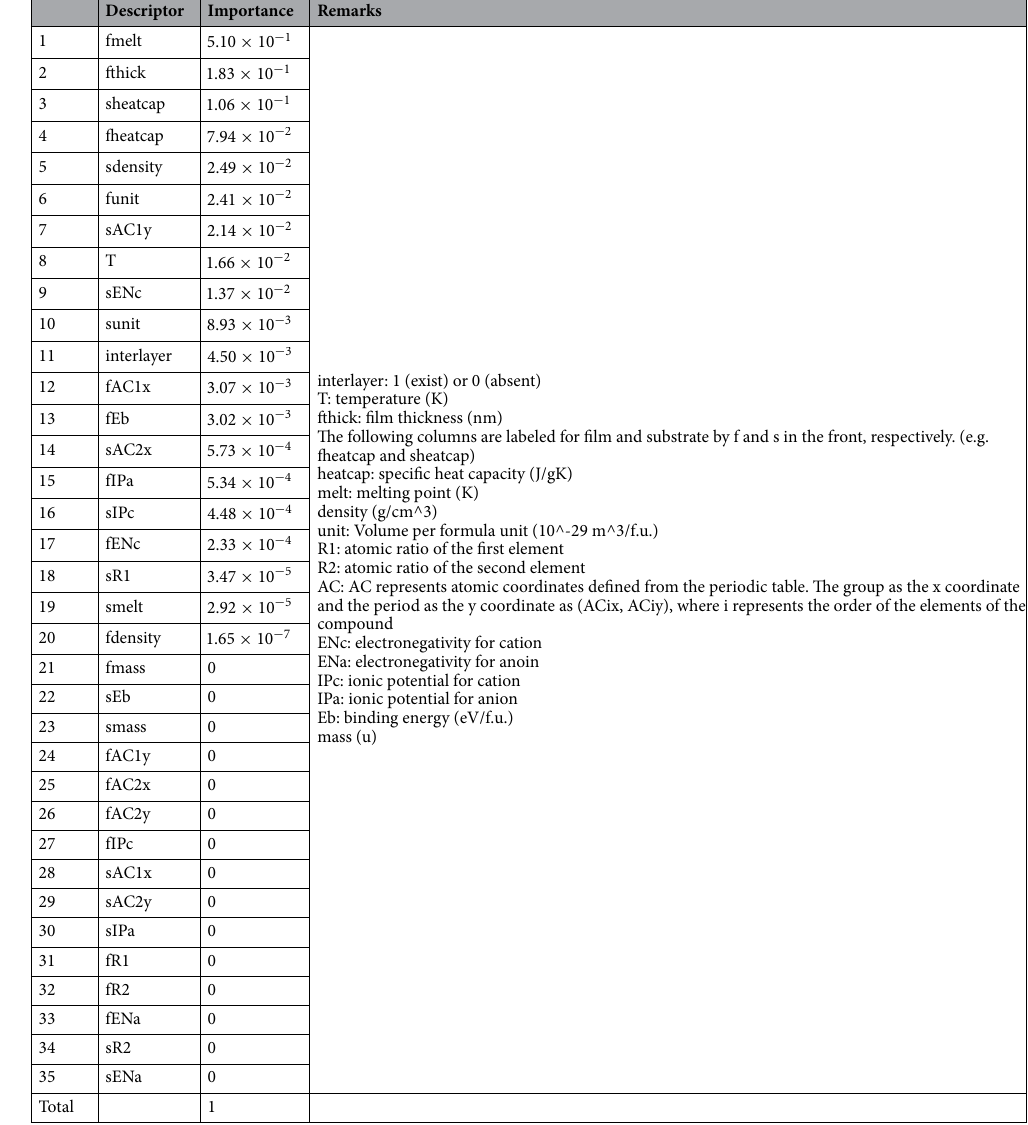
R2: atomic ratio of the second element AC: AC represents atomic coordinates defined from the periodic table. The group as the x coordinate and the period as the y coordinate as (ACix, ACiy), where i represents the order of the elements of the compound ENc: electronegativity for cation ENa: electronegativity for anoin IPc: ionic potential for cation IPa: ionic potential for anion Eb: binding energy (eV/f.u.)